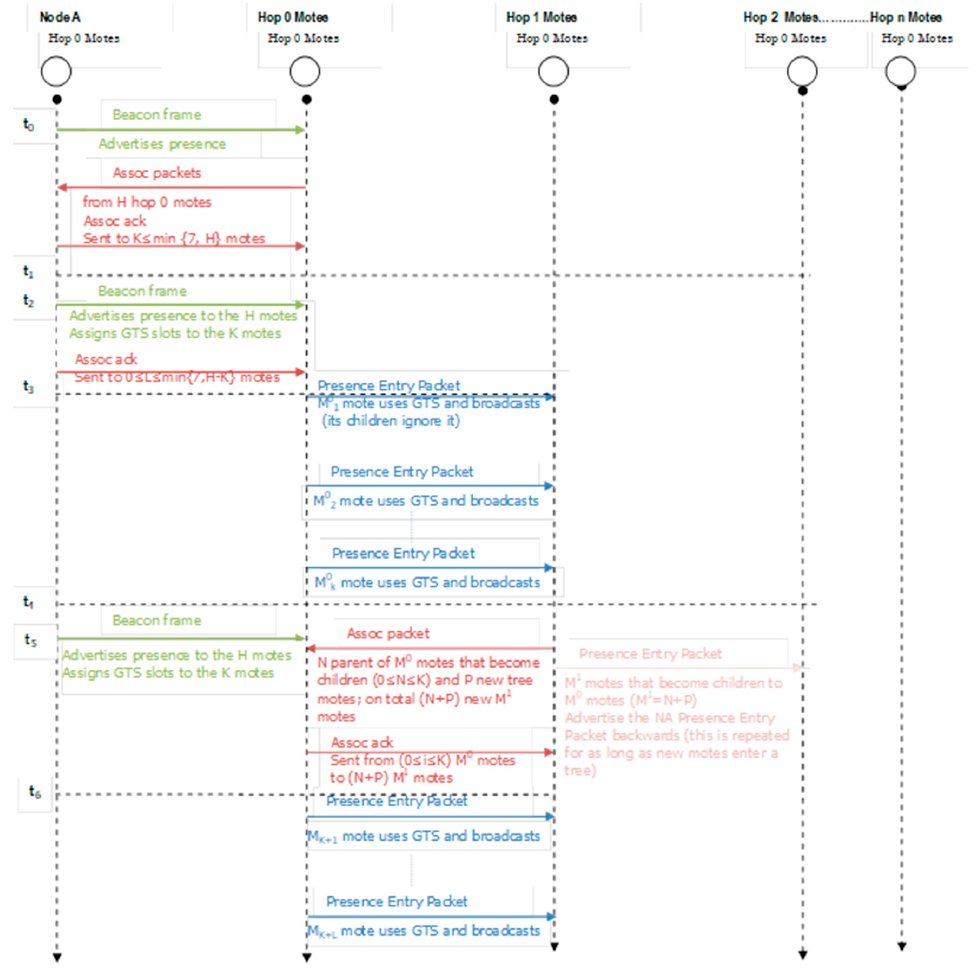
Figure 6. Spatiotemporal example of overhead network traffic.